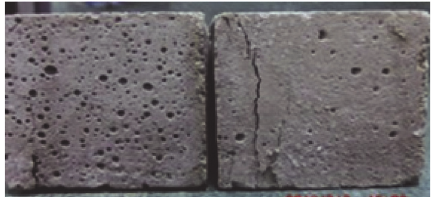
Figure 4: Mortar mixed with rubber particles compressive failure mode.